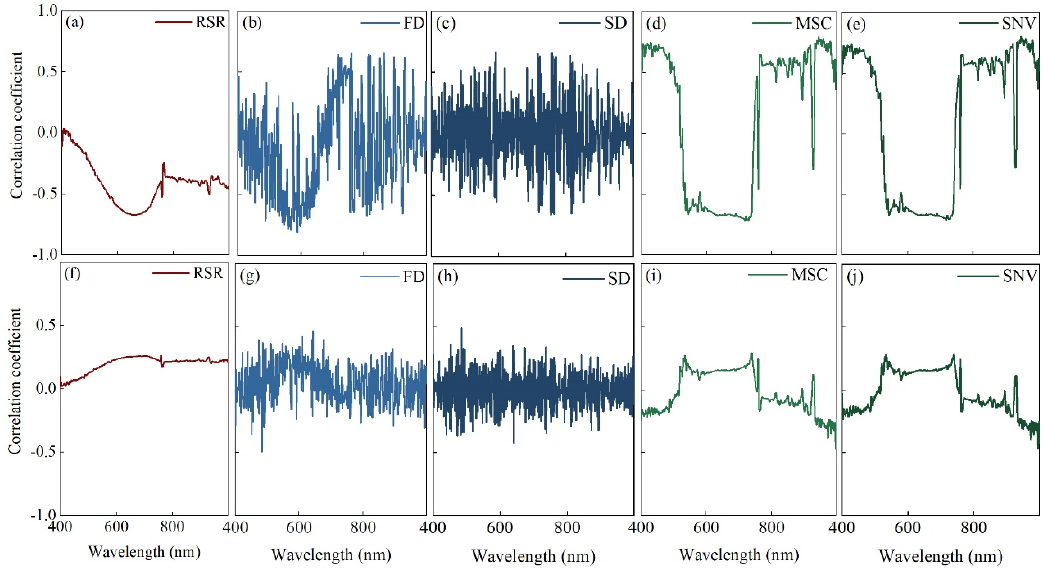
Figure 7. The correlation coefficients of five kinds of spectral data with SMC ( a − e ) and SSC ( f − j ) under different preprocessing methods. ( a , f ) raw spectral reflectance; ( b , g ) first derivative; ( c , h ) second derivative; ( d , i ) multiplicative scatter correction; ( e , j ) standard normal transformation.